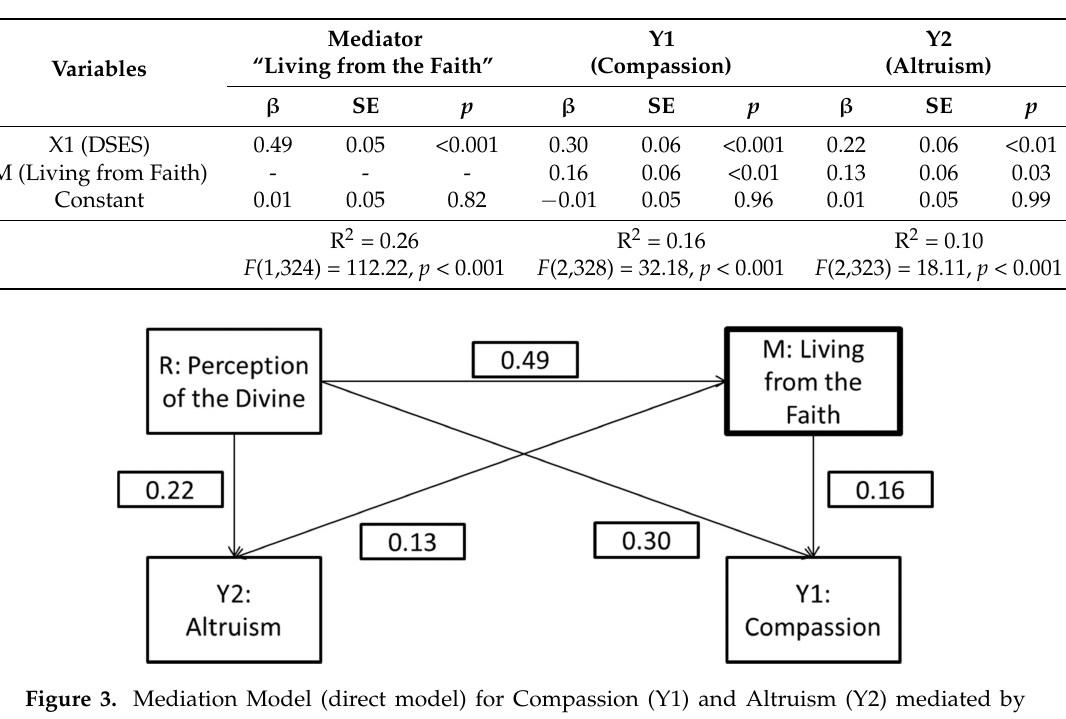
Table 7. Model coefficients for Compassion and Altruism mediated by “Living from the Faith” and the Perception of the Divine (DSES) as a regressor.